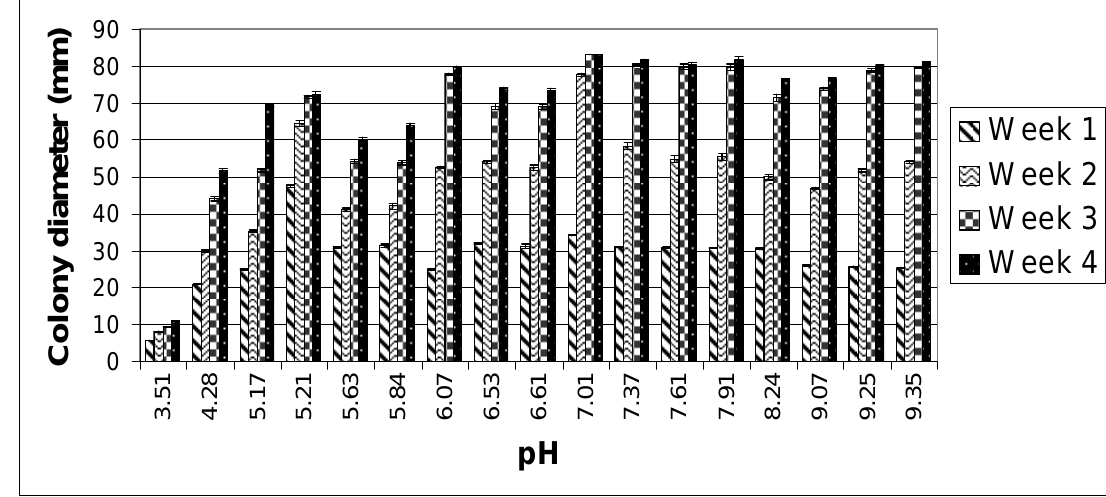
Figure 1. Comparison of colony diameters of C. globosum on buffered and unbuffered potato dextrose agar. The actual pH of each medium on the day of inoculation is listed on the x-axis. Colony diameters were measured every week. The maximum diameter of each plate was 83 mm. Mean and standard error of the mean are shown (n = 15